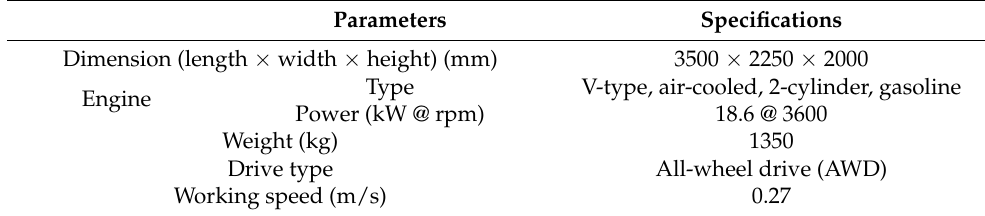
Figure 1. The self-propelled radish harvester used in this study. Table 1. The specifications of the radish harvester used in this study. Parameters